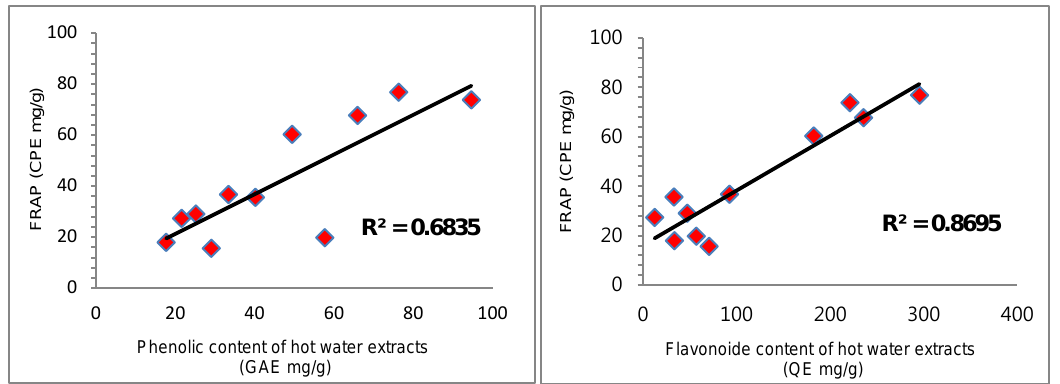
Figure 3. Correlation R 2 values of antioxidant activities between phenolic and flavonoid contents (hot water extracts).